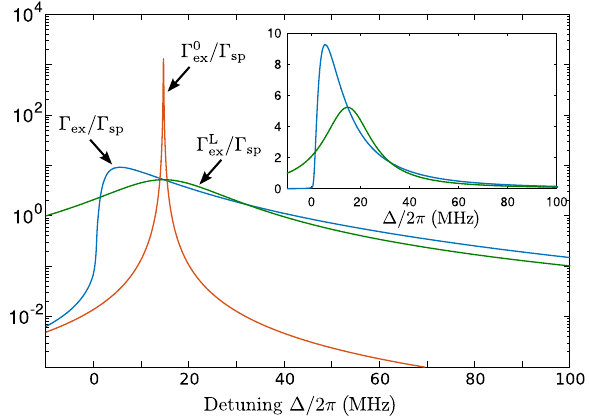
14. Comparison of the bare excitation rate Γ 0 an additional broadening mechanism, the full excitation rate Γ = Γ , Eq. (D3), and the approximate excitation rate Γ L ex sp Here, we use the parameters from the experiment; the interpar- ticle distance is r 0 ¼ a , and Rabi frequency Ω = 2 π ¼ 500 kHz. x The inset shows the same rates with linear scale.